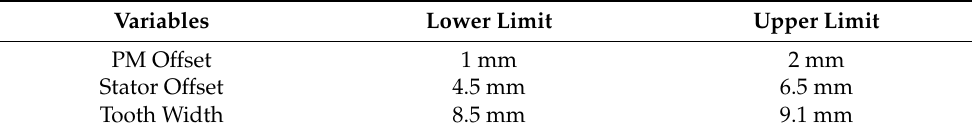
Table 1. Range of variables.